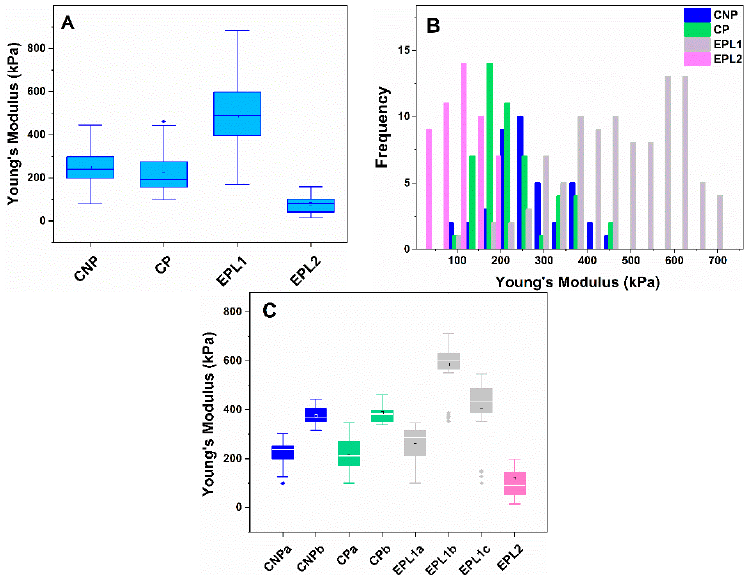
( B ) Histogram of Young’s modulus determined for platelets derived from the groups in panel A . ( C ) Box plot of the Young’s modulus determined for defined subpopulations of cells. Outliers of